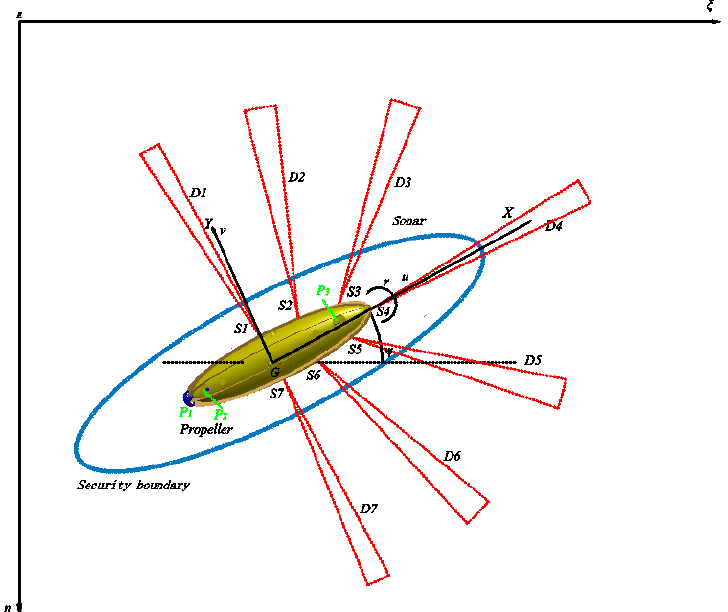
Figure 3. Scope of the repulsive force potential field of AUV.